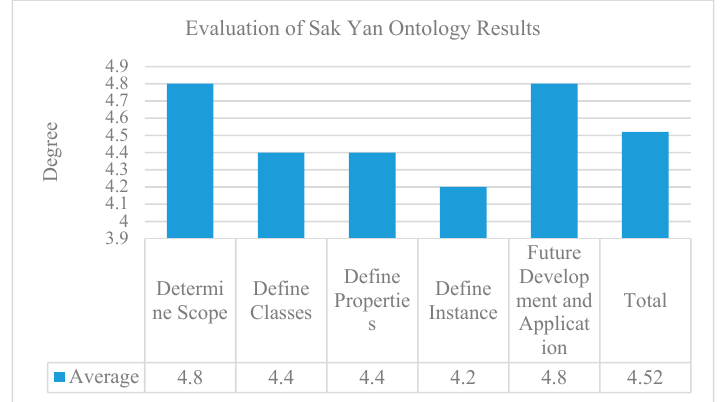
Figure 13. Evaluation of Sak Yan (SYO) ontology results by experts.